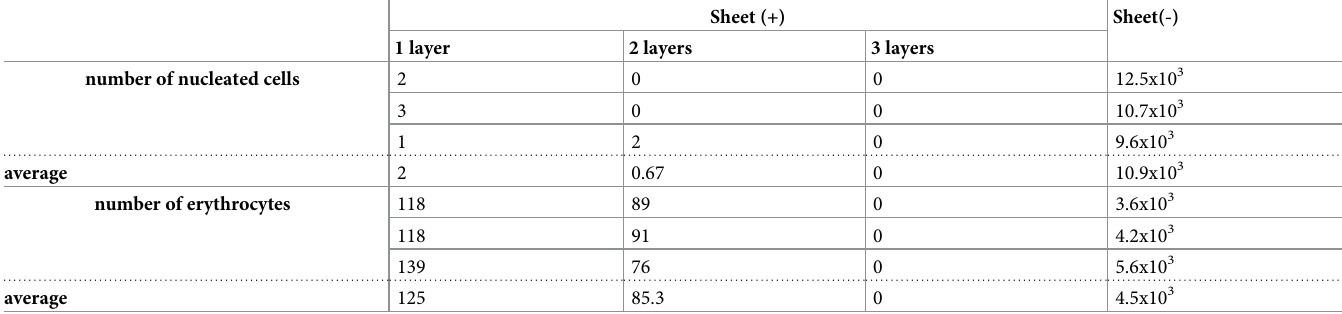
Table 4. Cell transit test according to the number of layers.